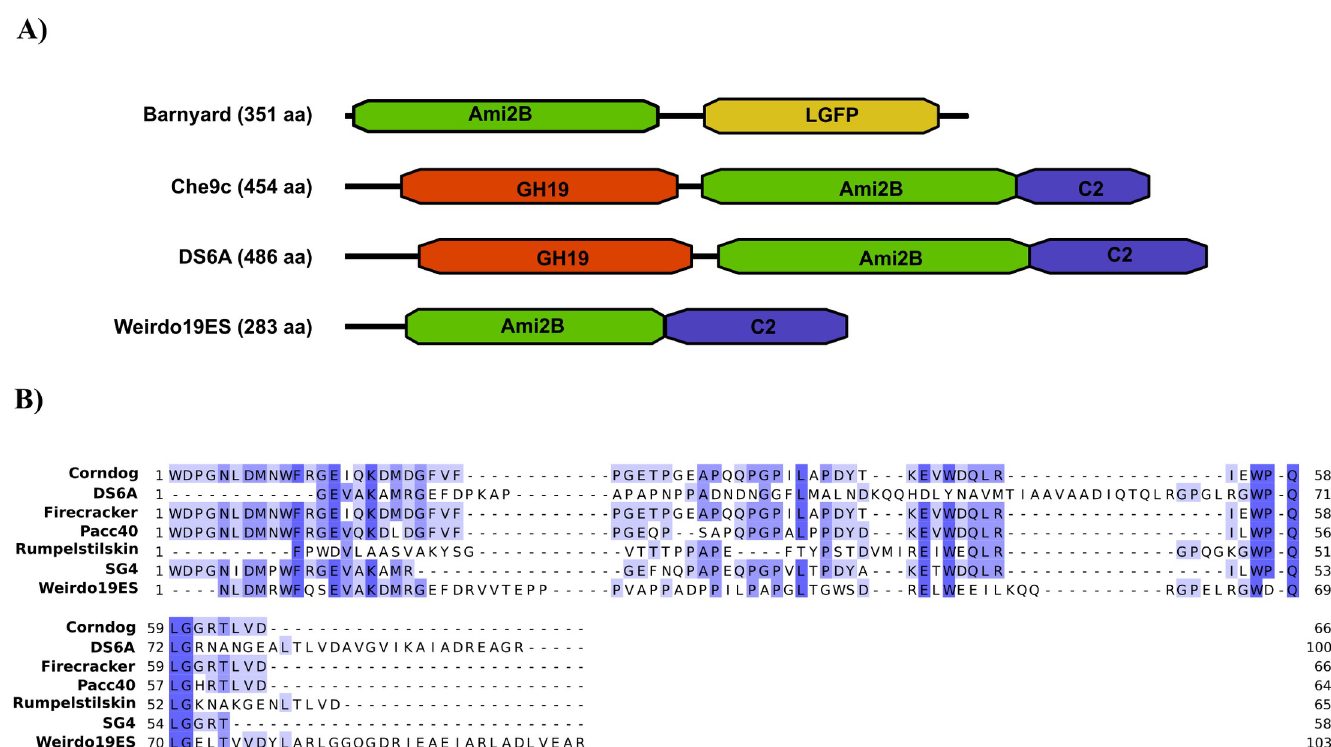
Fig 2. Schematic representation of the Lys A domains. A) Examples of the different LysA domain organization as represented by those for mycobacteriophages Barnyard, Wildcat, DS6A, and Weirdo19ES. B) ClustalW alignment was performed with the C2 domains of different reported Lys A enzymes. In this analysis, the C2 domain of DS6A Lys A displayed the highest homology to that of Weirdo19ES (29%). The alignment was visualized and edited by Jalview program [23].